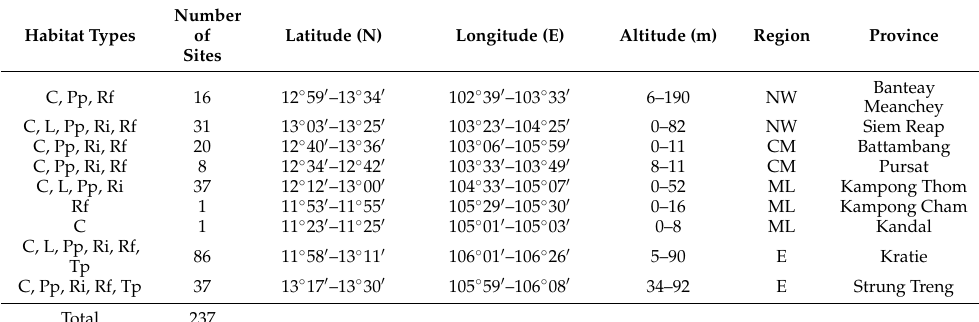
Table 1. Habitat types, number of sites, coordinate ranges, and altitudes of the sampling sites in nine provinces in the four regions of Cambodia. Habitat types are represented as C = canal, L = lake, Pp = permanent pond/swamp, Ri = river, Rf = rice field, and Tp = temporary pond/rain pool. The distribution regions are represented as NW = Northwest, CM = Cardamom and Elephant Mountains, ML = Mekong Lowlands, and E =